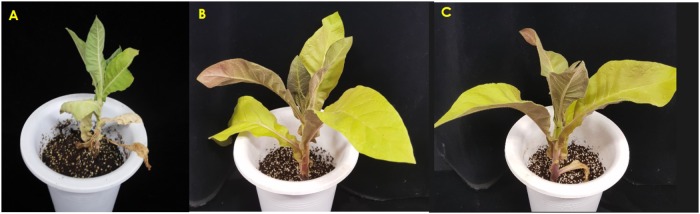
Comparisons of the degree of cold stress tolerance between 10-week-old WT (A) and independent T2-Ros1 lines (B,C) under the cold stress. Photos were taken on the 7th day after removal from cold stress condition (0°C) to the normal growing condition (22°C).